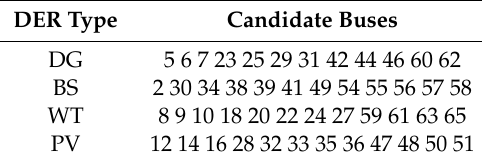
Table 13. Candidate Buses for DER